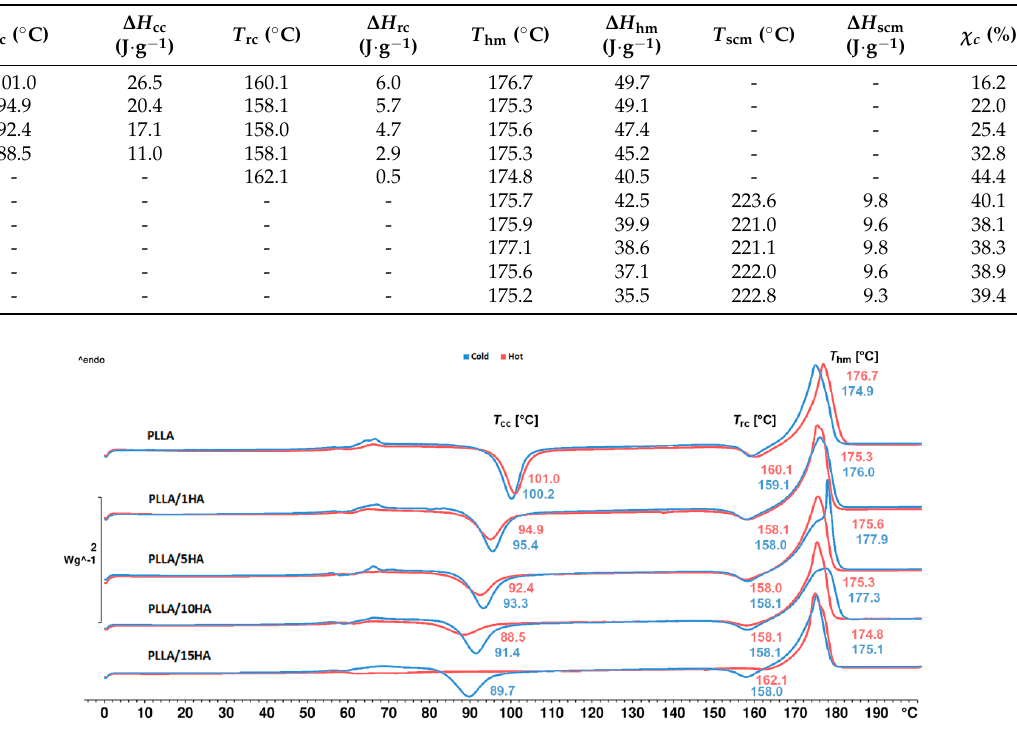
Figure 1. DSC curves of the PLLA a PLLA/HA nanocomposites obtained during the first heating.